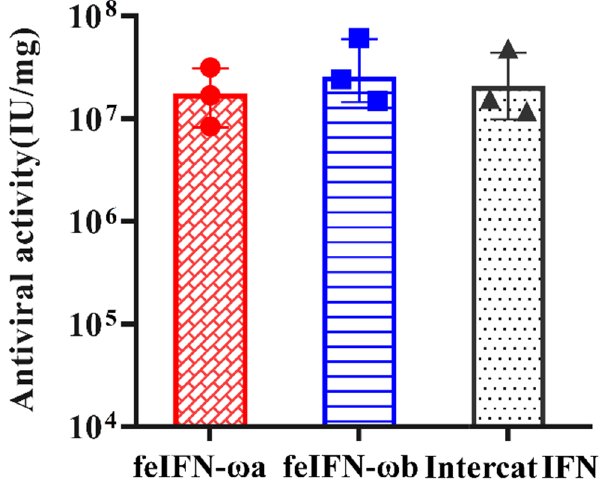
Figure 5. The antiviral activities of the recombinant feIFN- ω a and feIFN- ω b proteins against vesicular stomatitis virus (VSV) propagated on F81 cells, as determined by microdose cytopathic effect inhibition assays. INTERCAT IFN is an antiviral drug that we used as a positive control, and F81 cells untreated with the IFNs were used as negative control. The dots, square and triangle in the bars mean each test value of the three repetitions, respectively.